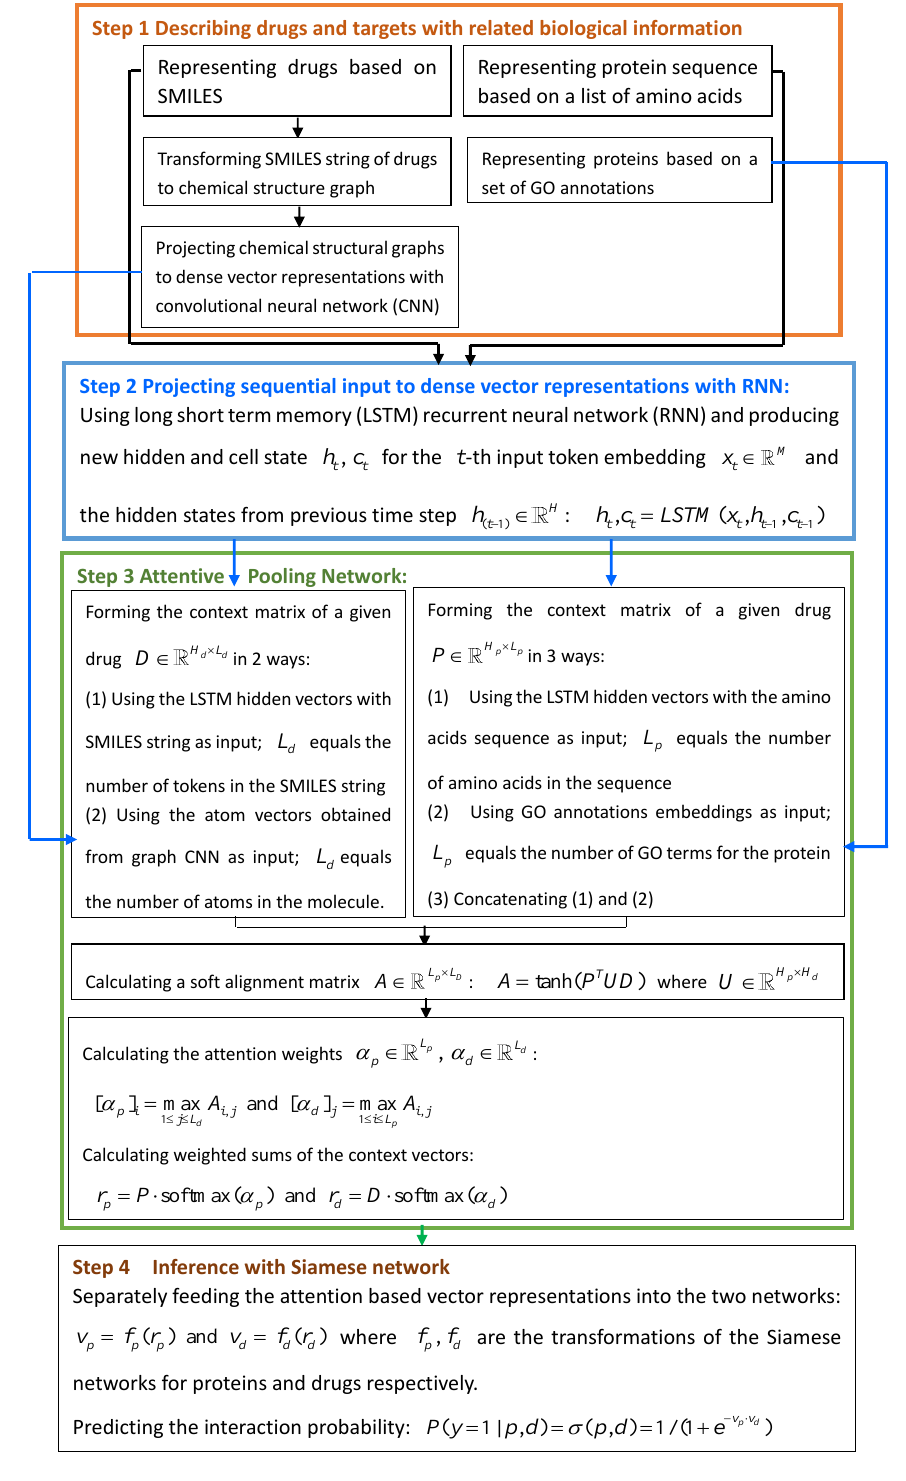
Figure 11. The flowchart of End-to-End Neural Network